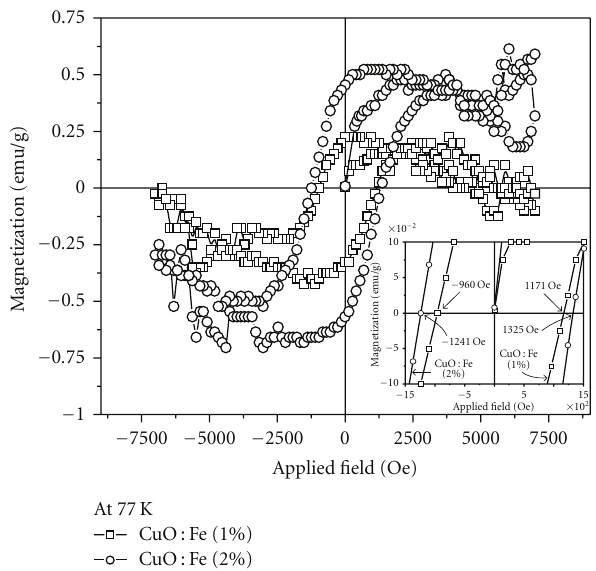
Figure 12: Hysteresis behavior of bulk 1 and 2% “Fe”-doped CuO samples annealed at 900 ◦ C/12h in air measured at 77K. Inset shows the exchange bias